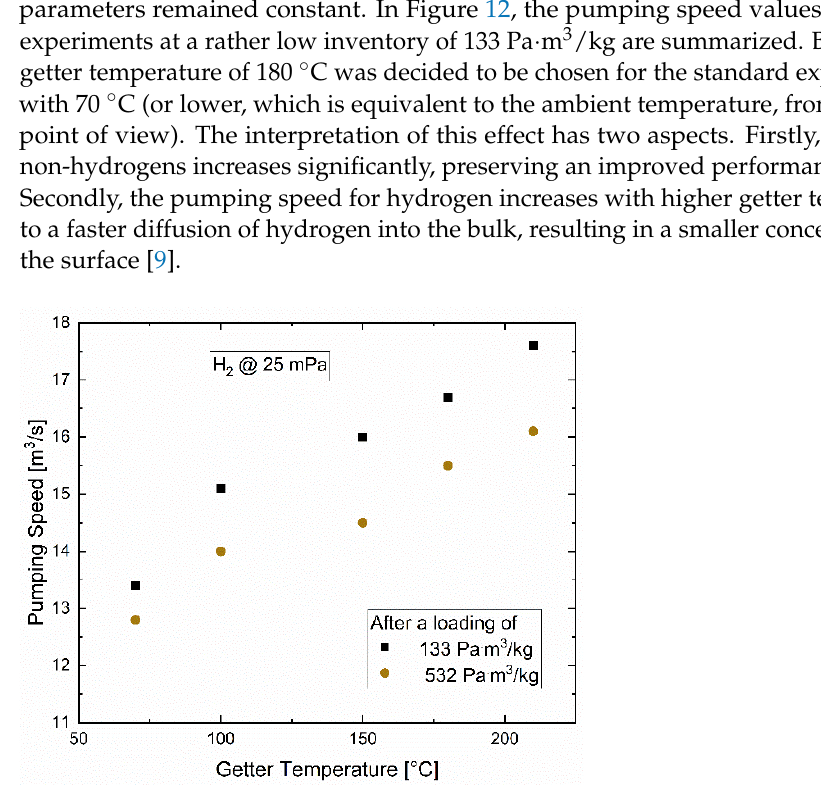
Figure 11. Pumping speed curves at different pressures with a growing inventory of H 2 with ZAO ® at temperatures of 70 °C or below.